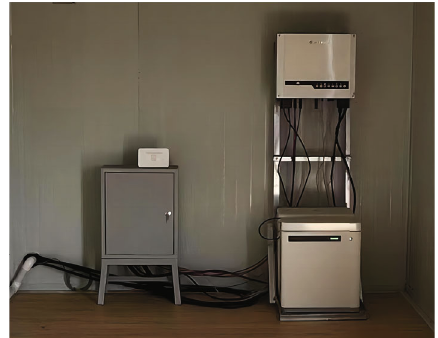
Figure 9: Inverter and control cabinet diagram.